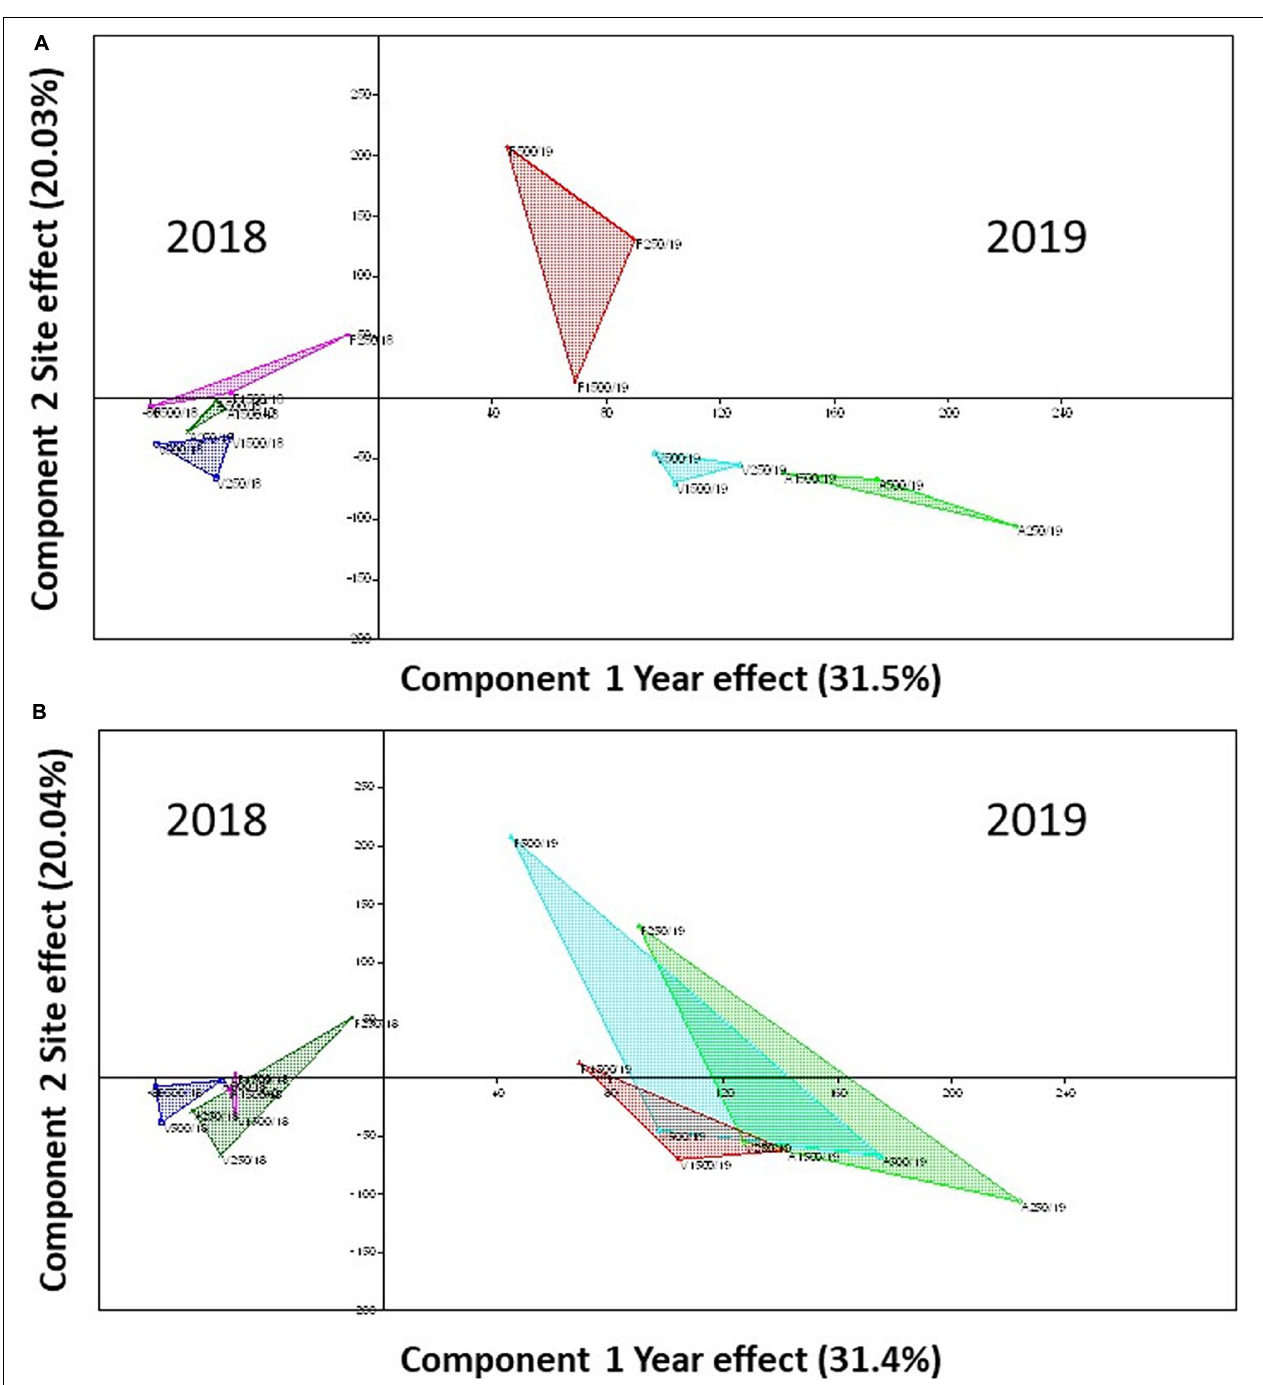
FIGURE 5 | The canonical correspondence analyses to test the species overlap between sites and years, where sites and years were used as components and species densities as variables. (A) species composition by sites; (B) species composition by distances from beehives. Green color represents site A, blue represents site V, and red represents site F panel in (A) , while the green color represents 250 m, blue represents 500 m, and red 1,500 m distances from beehives in panel (B) .